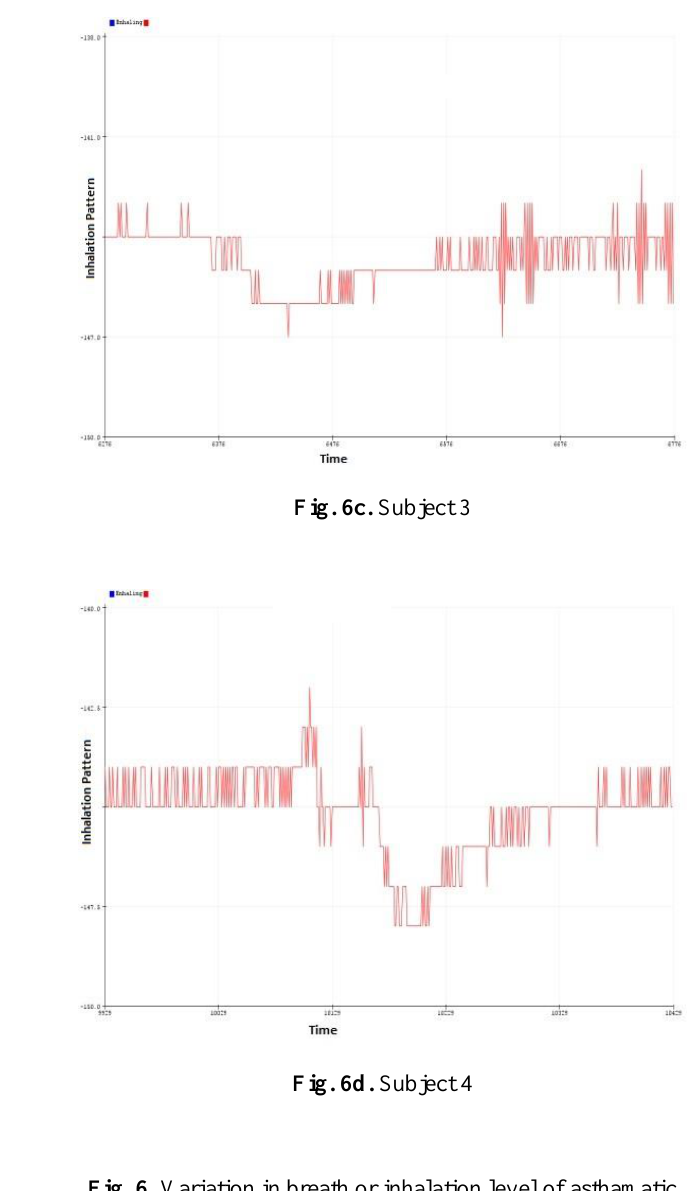
Fig. 6. Variation in breath or inhalation level of asthamatic patients with respect to time, which ranges from -140 liters to -156